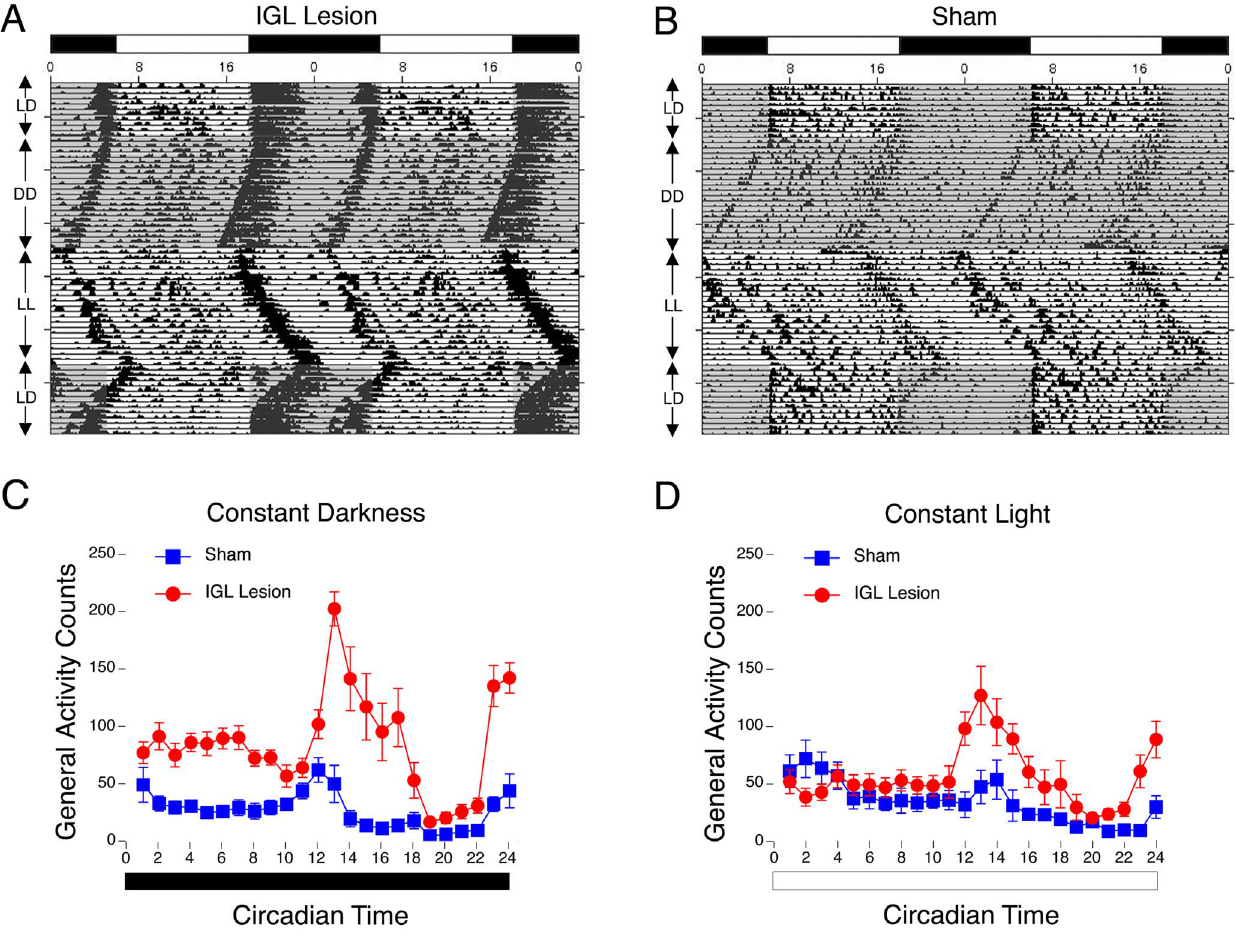
Figure 5. Effects of lesions on behavior in constant conditions. Double-plotted actograms from 1 representative animal with complete IGL lesions ( A ) and 1 representative sham-operated animal ( B ) during periods of LD, DD, LL, and LD. Note the increase in activity at night in animals with IGL lesions, which persists and free-runs in constant conditions. ( C ) 5-day average activity patterns of sham-operated animals (Blue squares) and animals with complete IGL lesions (Red circles) kept in DD and in LL ( D ). Note that although constant light suppresses activity in IGL lesioned animals, the same overall pattern of activity is observed. doi:10.1371/journal.pone.0067387.g005 PLOS ONE |